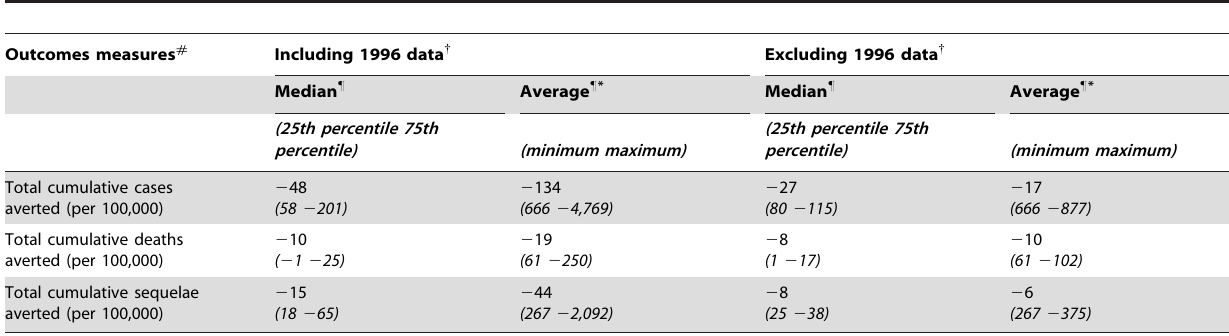
Table 3. Sensitivity analysis of number of meningitis cases, deaths and sequelae averted correlated with introduction of IDSR: Paired-comparison of outbreaks before (1996–2002) and after (2003–2007) IDSR implementation: